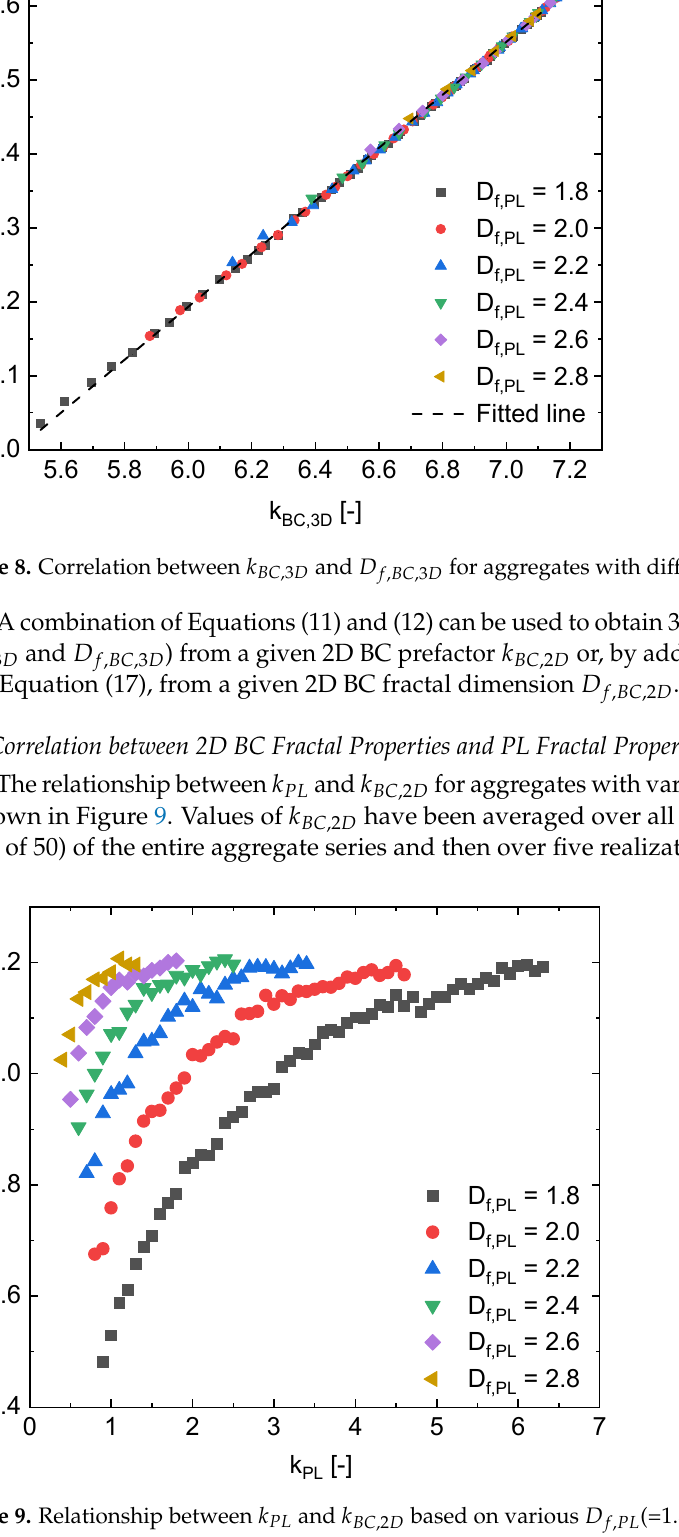
𝑘 (cid:3003)(cid:3004),(cid:2871)(cid:3005) for the aggregates